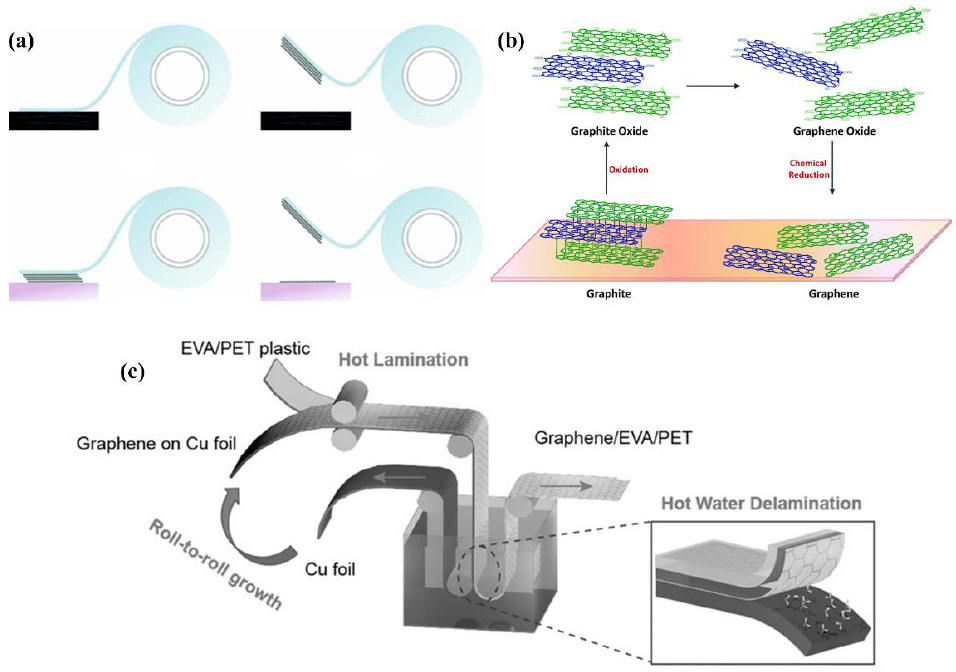
Figure 1. ( a ) Schematics of mechanical exfoliation method [38]; ( b ) Schematic of chemical exfoliation method [39]; ( c ) Schematic of roll-to-roll production of graphene from a Cu foil to a target substrate [40]. ( a ) Reprinted with permission from Ref. [38]. Copyright 2011, WILEY. ( b ) Reprinted with permission from Ref. [39]. Copyright 2014, RSC. ( c ) Reprinted with permission from Ref. [40]. Copyright 2015, WILEY.